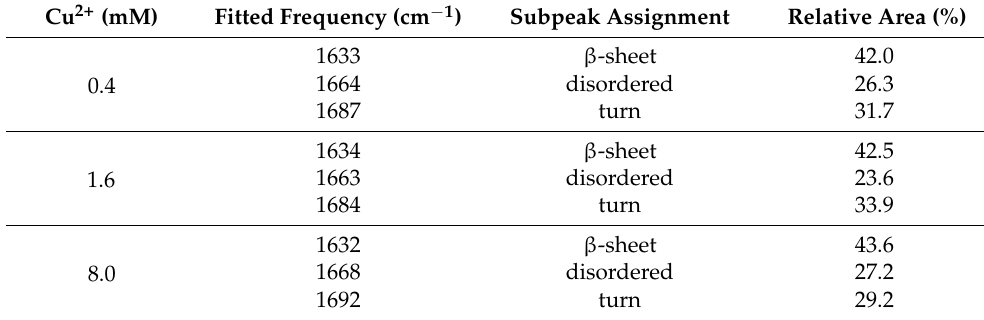
Figure 3. FTIR spectra of α -synuclein amyloid fibril under the influences of different concentrations of Cu 2+ and curve-fitting results in the amide I region. ( a ) 0.4 mM; ( b ) 1.6 mM; ( c ) 8.0 mM; solid black line: measured spectrum; dash red line: overall fit; solid blue line: fitted subpeak. a.u.: arbitrary unit. Table 3. Curve-fitting results of the FTIR spectra of α -synuclein amyloid fibril under the influence of different concentrations of Cu 2+ .